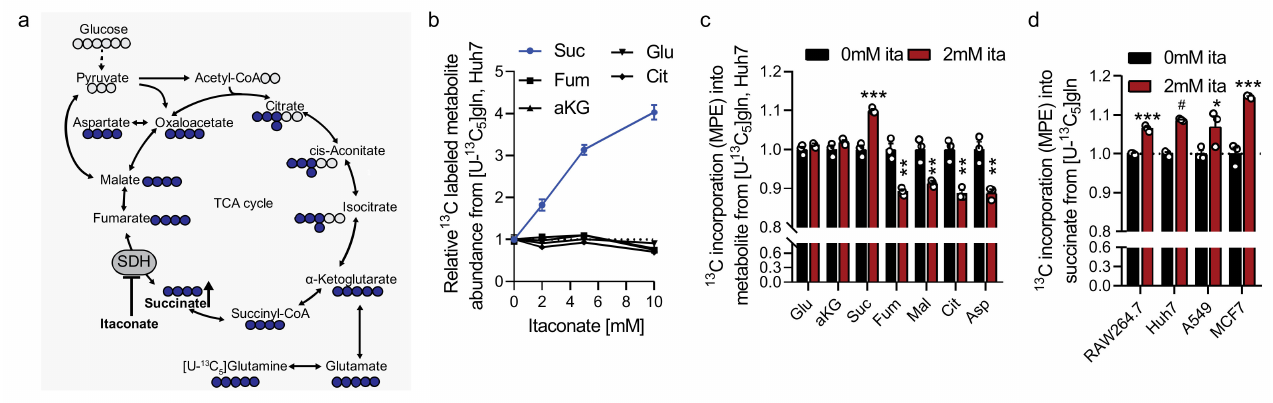
Figure 3. Itaconate influences glutamine metabolism. ( a ) Schematic depicting carbon incorporation into tricarboxylic acid (TCA) cycle intermediates from [U- 13 C 5 ]glutamine (blue). Open circles depict 12 C, closed circles 13 C carbon. ( b ) Labeled metabolite level (depicted as abundance times mole percent enrichment (MPE)) from [U- 13 C 5 ]glutamine in Huh7 cells cultured in the presence of 2 mM itaconate for 4 h. ( c ) 13 C incorporation (mole percent enrichment, MPE) into metabolites from [U- 13 C 5 ]glutamine in Huh7 cells cultured for 48 h. ( d ) 13 C incorporation into succinate from [U- 13 C 5 ]glutamine in diverse cell types in the presence of 0 mM or 2 mM itaconate after 48 h. Data are depicted as mean ± s.e.m. obtained from 3 cellular replicates. Students t -test with no adjustment for multiple comparisons and * p < 0.05, ** p < 0.01, *** p < 0.001, # p <